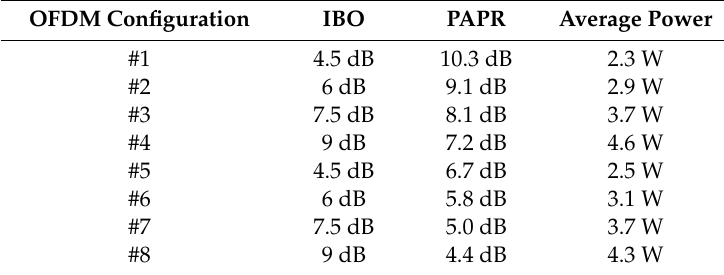
Table 4. Real IBO test.